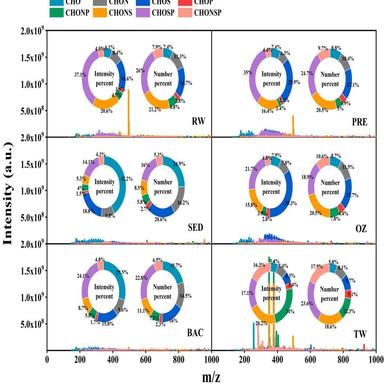
Relative intensity and number compositions of CHO, CHON, CHOS, CHOP, CHONP, CHONS, CHOSP, and CHONSP compound categories in water samples from the DWTP.